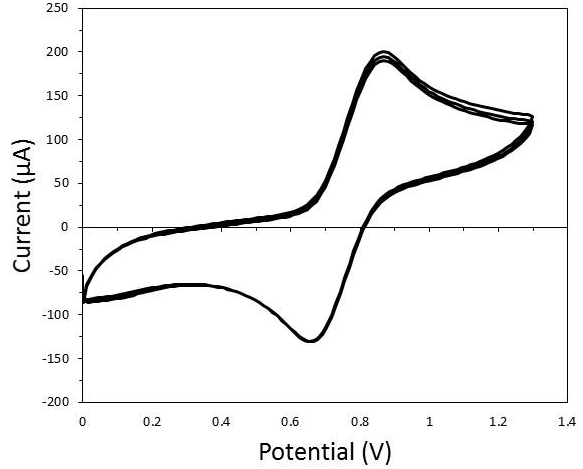
Figure 10. CV cathodic sweep of Cu2FcOH potential vs. (NHE) in dry degassed DMF.